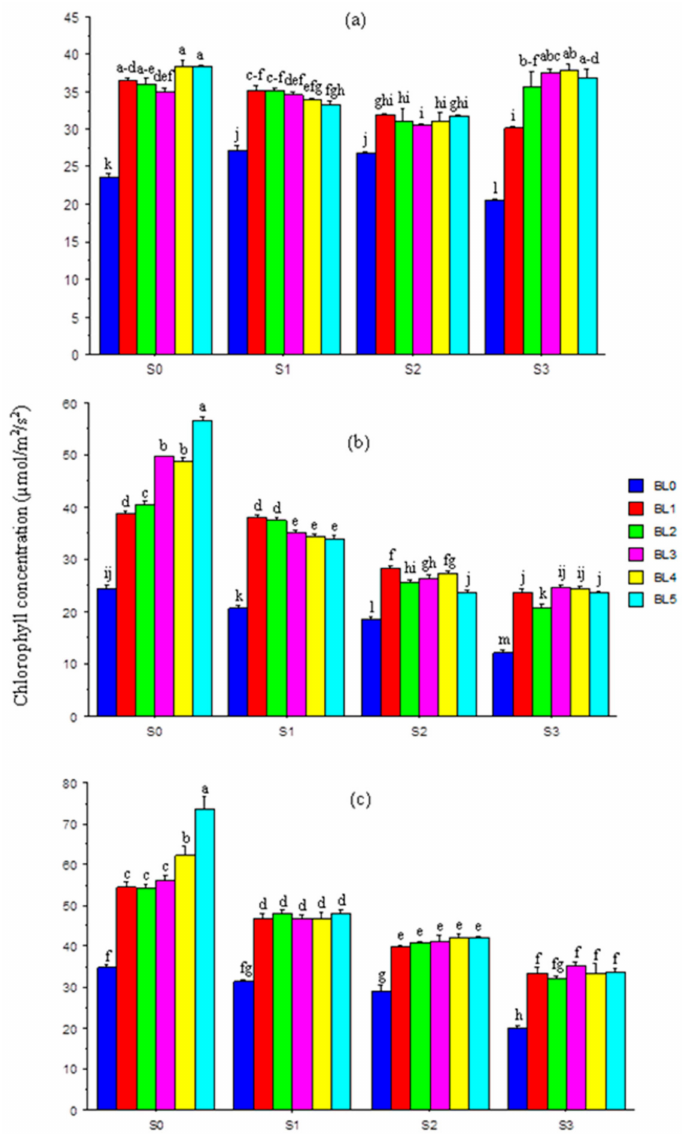
Figure 4. Interaction effects of salinity × brassinolide on chlorophyll content of soybean at 20 ( a ), 30 ( b ) and 40 ( c ) DAS. BL—brassinolide; S—salinity; DAS—days after sowing; BL0—no BL application (control); BL1—BL application at seedling; BL2—BL application at flowering; BL3—BL application at podding; BL4—BL application at seedling + flowering; BL5—BL application at seedling + flowering + podding; S0—1.10 mM/L (control); S1—32.40 mM/L; S2—60.60 mM/L; Scheme 3. 30 mM/L.